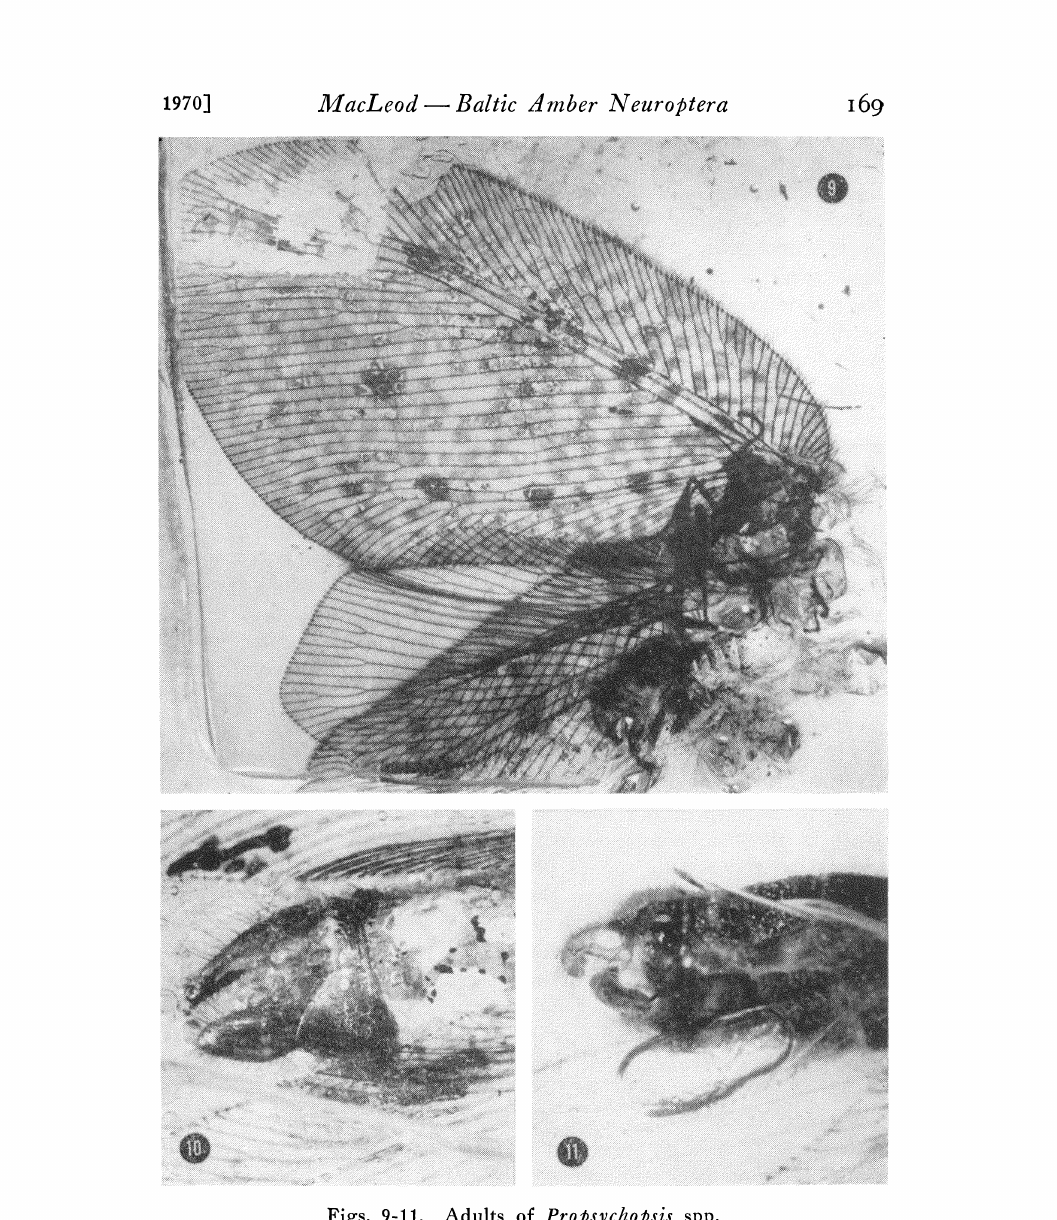
Figs. 9-11. Adults of Propsychopsis spp. Fig. 9. Paratype (MCZ) of Propsycholsis lapicidae n. sp. illus- trating venation and maeulation pattern of fore wing. Fig. 10. Holotype / (Berlin Mus.) of Proksychopsis laic:.dae n. sp. showing detail of eetoproets, latero-dorsal view. Fig. 11. Holotype (Berlin Mus.) of Prolsychopsis hageni n. sp. showing detail of abdomen and eetroproets, latero-ventral